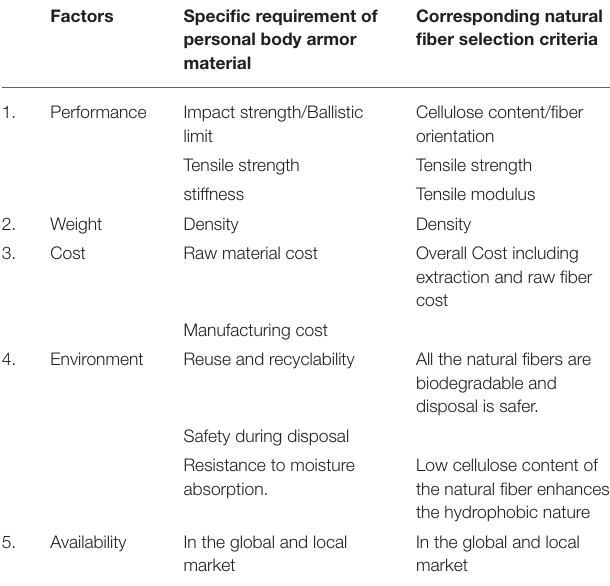
TABLE 1 | Factors affecting Personal body armor material